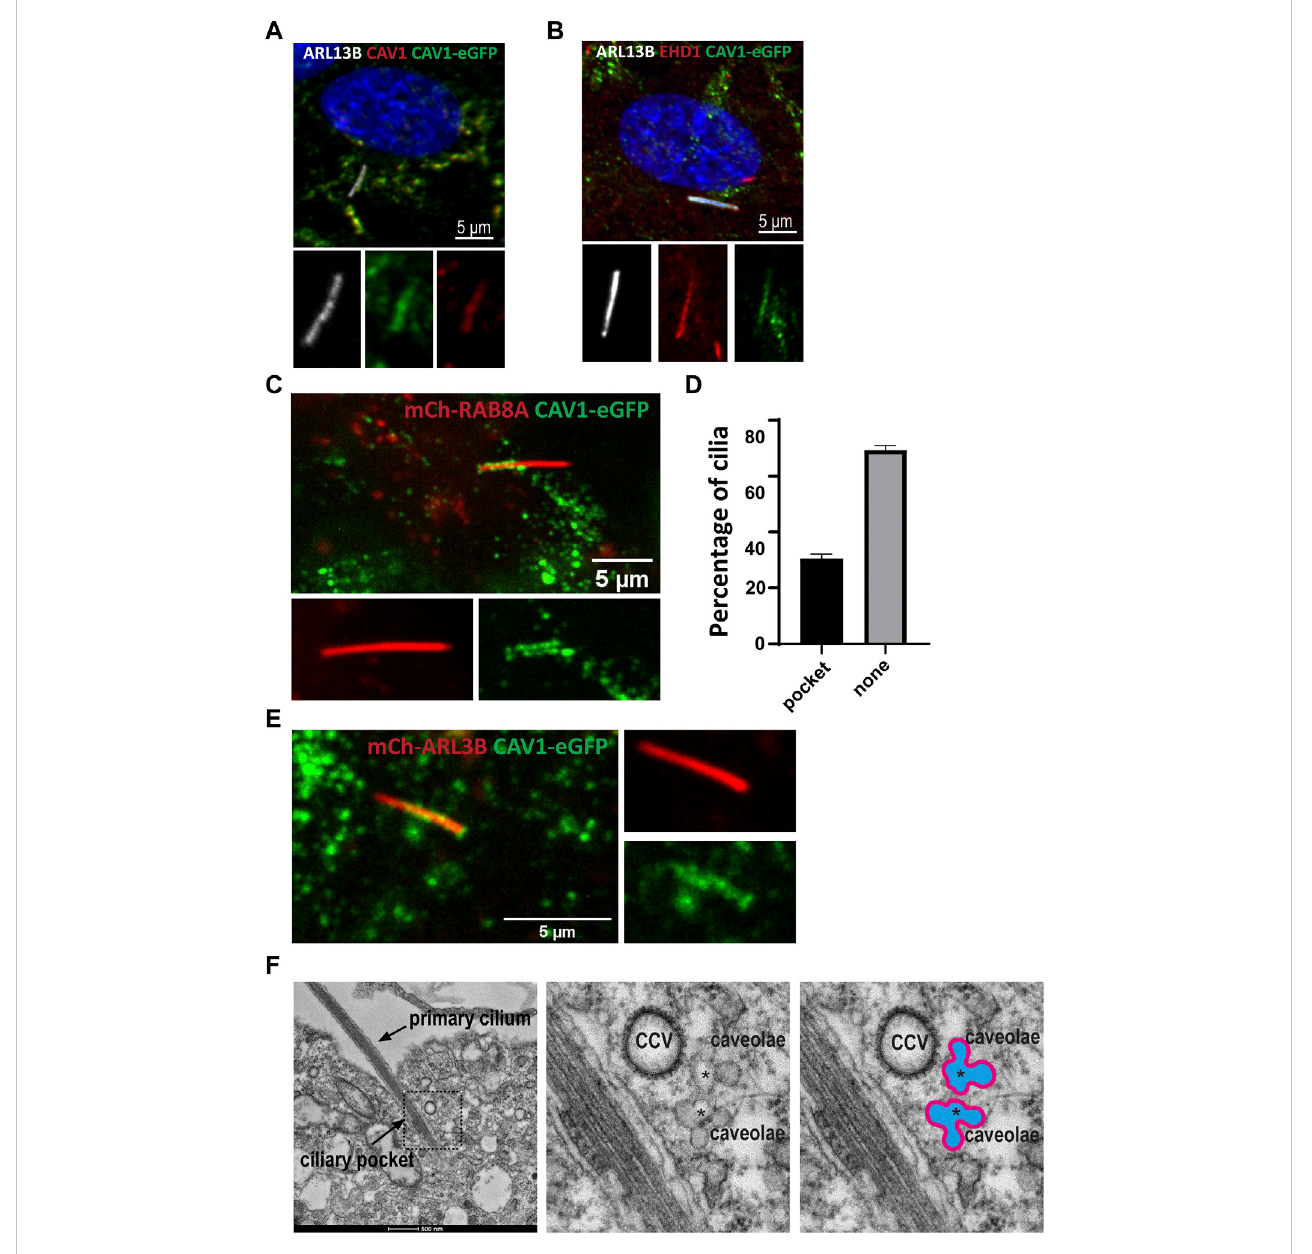
Dynamic CAV1 localization at the ciliary pocket (A) A stable RPE1Flp-In cell line expressing eGFP-tagged CAV1 was generated for live cell imaging purposes. The recombinant CAV1 (green) colocalizes with both endogenous CAV1 stained with an anti-CAV1 antibody (red) and the ciliary marker ARL13B (white) (B) The ciliary pocket marker EHD1 (red) colocalizes with CAV1 (green) and the ciliary protein ARL13B (white). (C) RPE1 CAV1-eGFP cells stably expressing RAB8A-mCherry underwent live imaging (5 – 20 min) showing dynamic accumulation of CAV1-eGFP at the cilia pocket. This is a single time frame representation (D) Quanti fi cation of CAV1-eGFP ciliary localization from time frame images as in C (n = 75). (E) Single time frame of RPE1 CAV1-eGFP cells stably expressing ARL13B-mCherry shows similar cilia localization as in (C) . (F) Representative TEM micrograph of a primary cilium in RPE1 cells